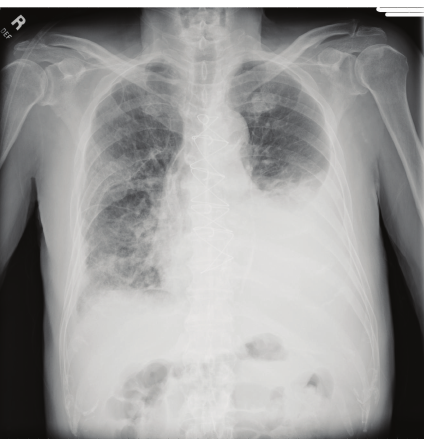
Figure 1: Chest radiograph showing moderate size left pleural e ff usion.